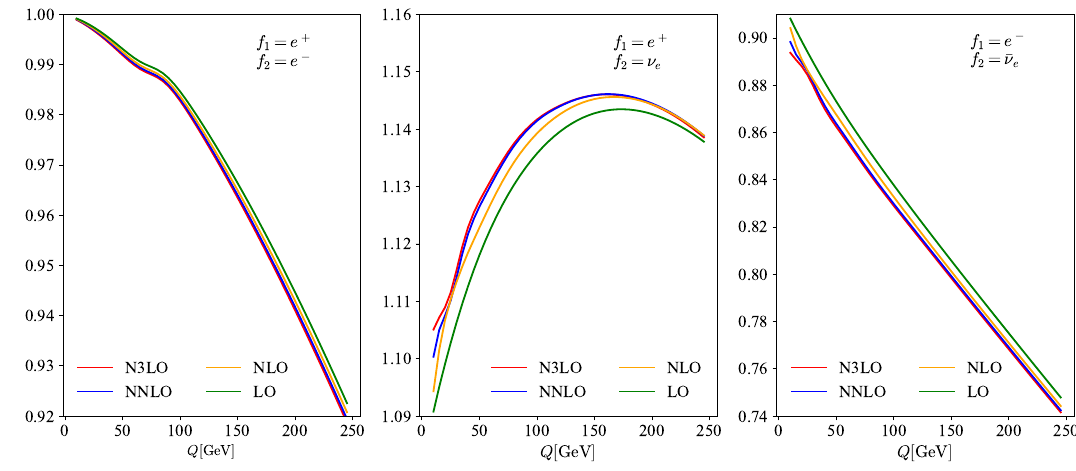
( Q 2 ) / Σ N k LO ( Q 2 ) pp p ¯ p